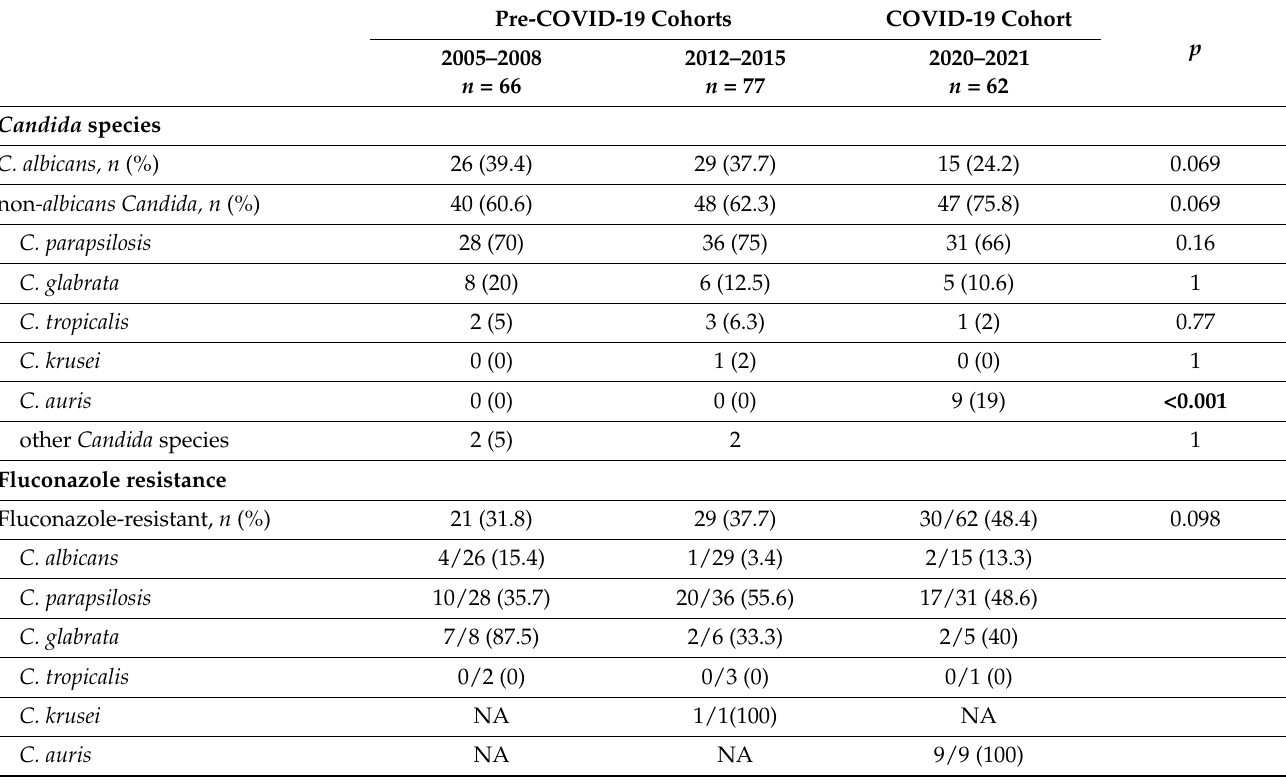
Table 2. Candida species and fluconazole resistance in the three candidemia cohorts.